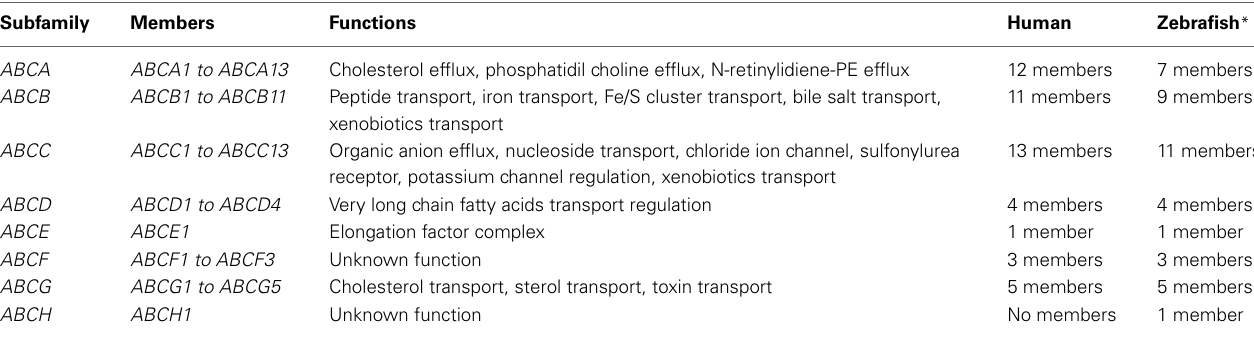
Table 1 | List of known ABC genes, functions and number of members found in human and zebrafish genomes. Subfamily